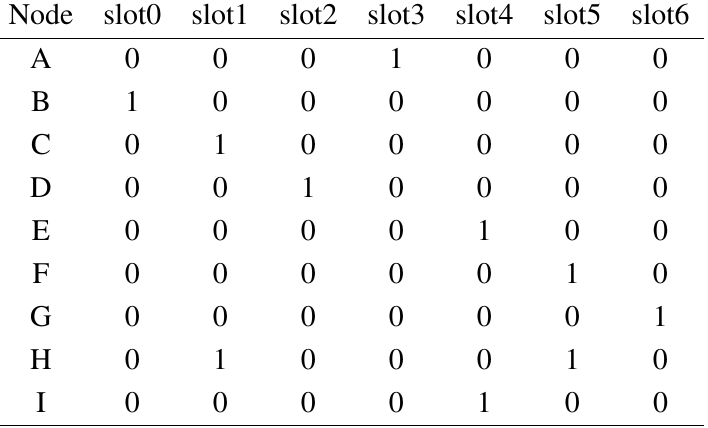
Table 5. Slot schedule with SERENA tree or three-hop